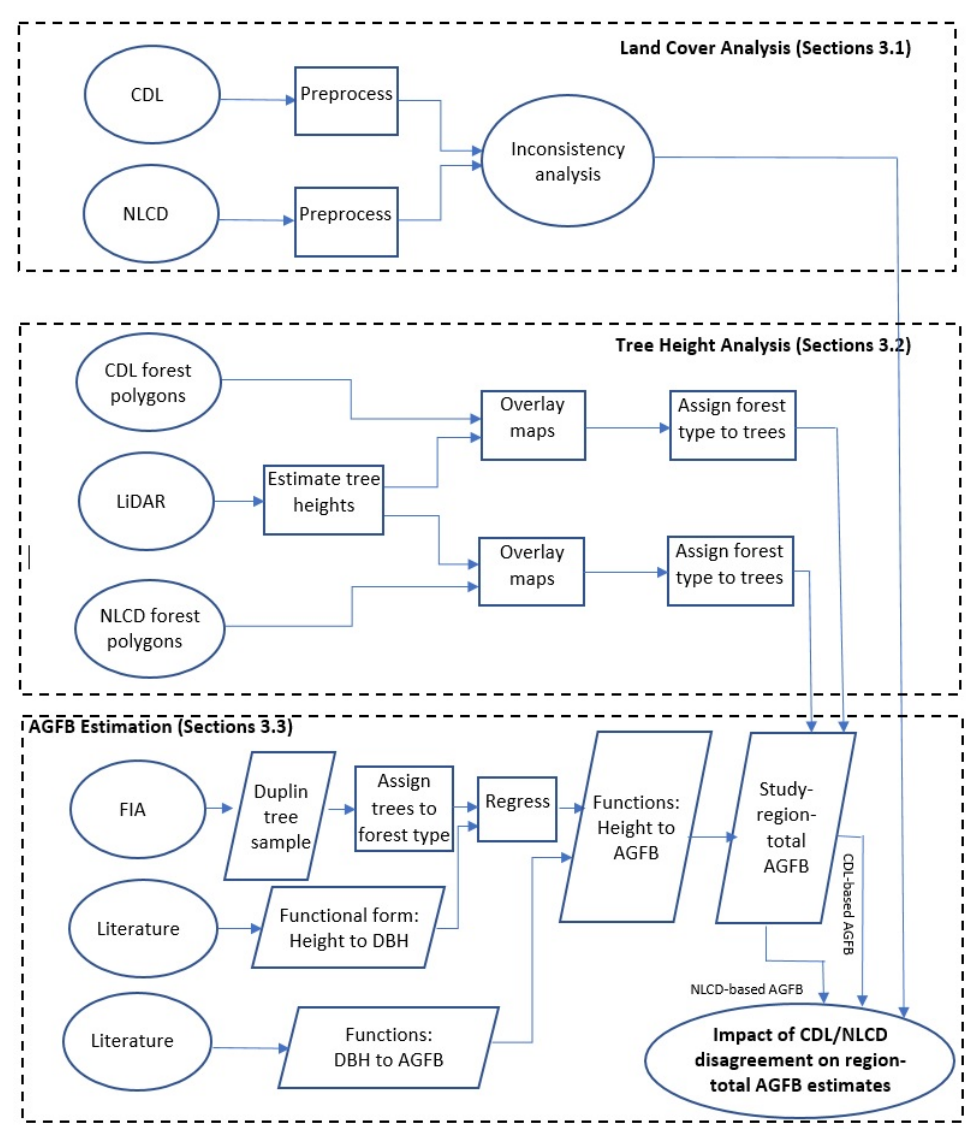
Figure 2. Schematics of the analysis. Symbols: ovals—start/end; parallelogram—input or output; rectangle—process.